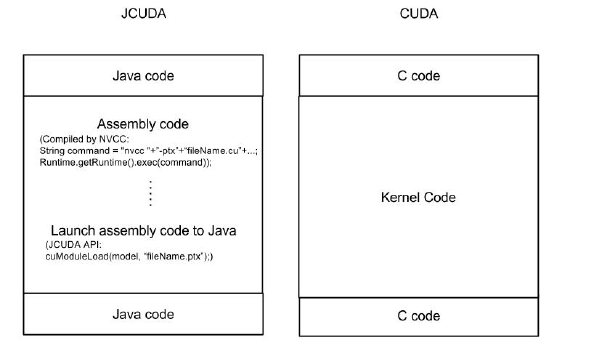
Fig. 4. Layout Comparison of JCuda and